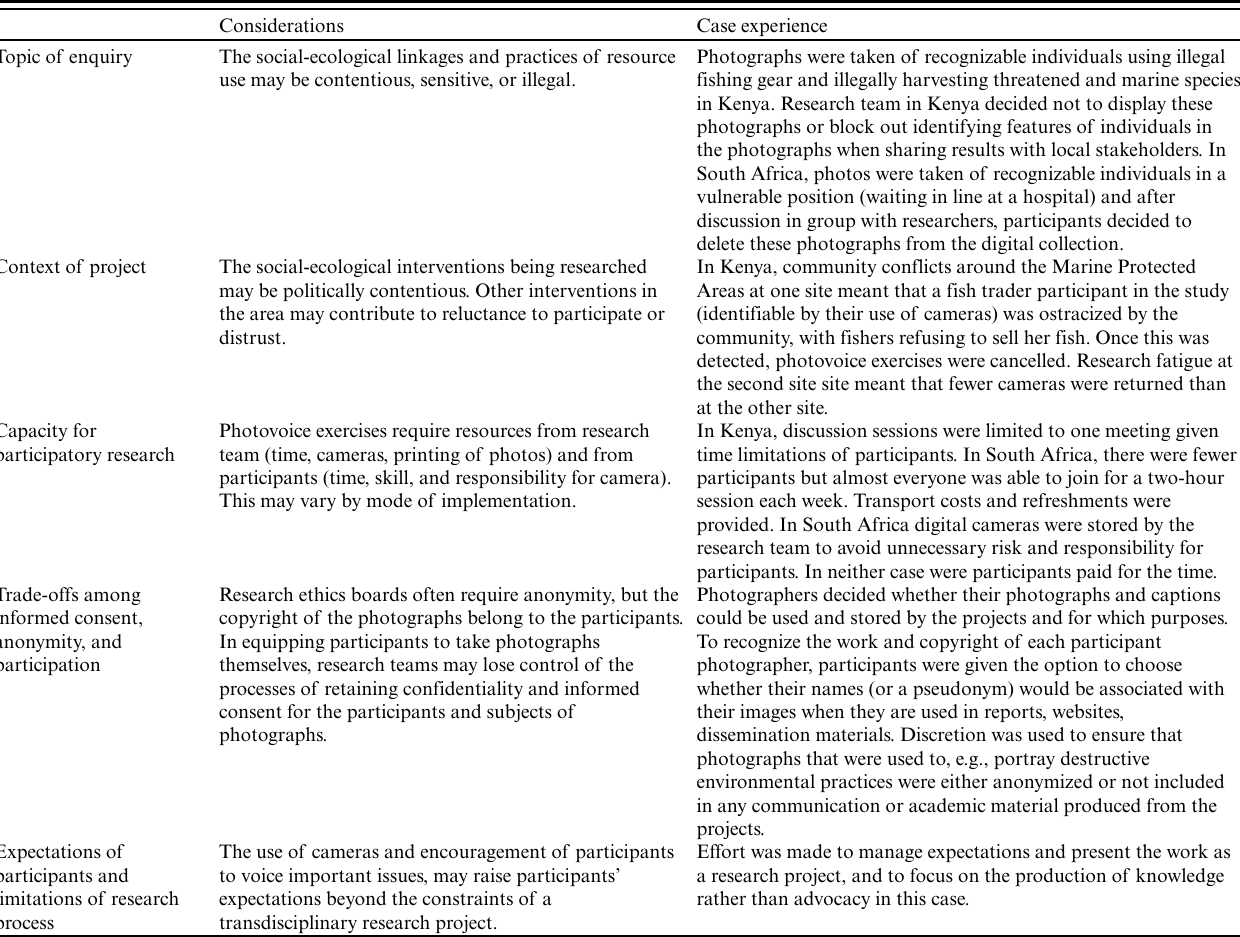
Table 3 . Ethical considerations in using